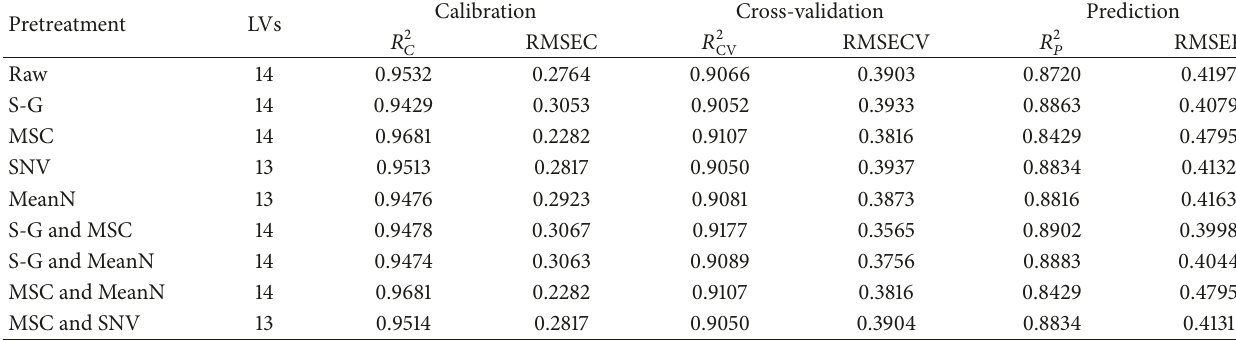
Table 2: Prediction results for SSC by PLS with different pretreatments in calibration, validation, and prediction processes.